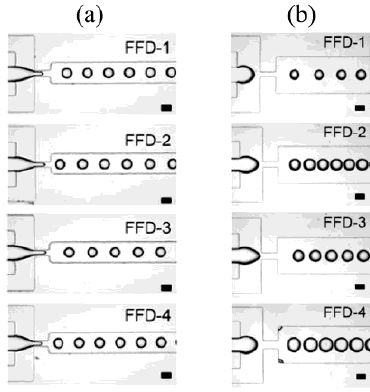
Figure 7. Quadruple droplet generator: ( a ) same dimensions of the orifices from FFD-1 to FFD-4; ( b ) FFDs with different widths of the orifices. Reprinted from [65] with permission from Royal Society of Chemistry